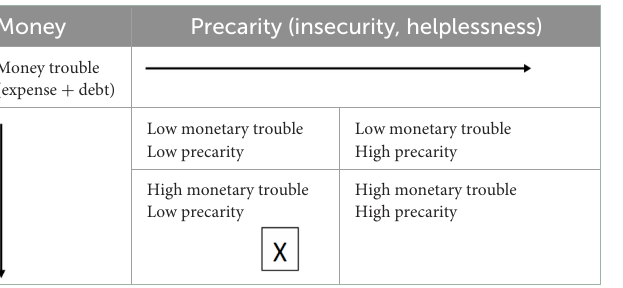
TABLE 6 Evolution of typology, step 2c–Information and precarity.